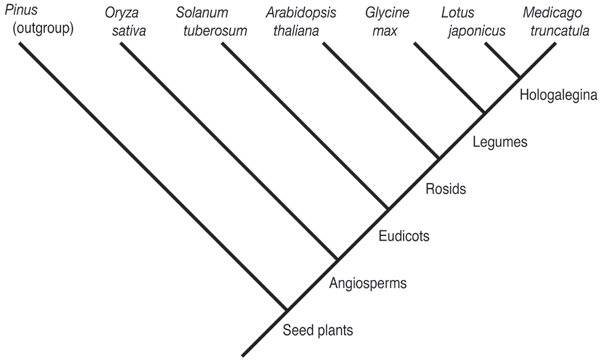
Accepted species tree for seven plant model species. Names of clades are indicated at internal nodes. See text for discussion of strength of evidence for this phylogeny.